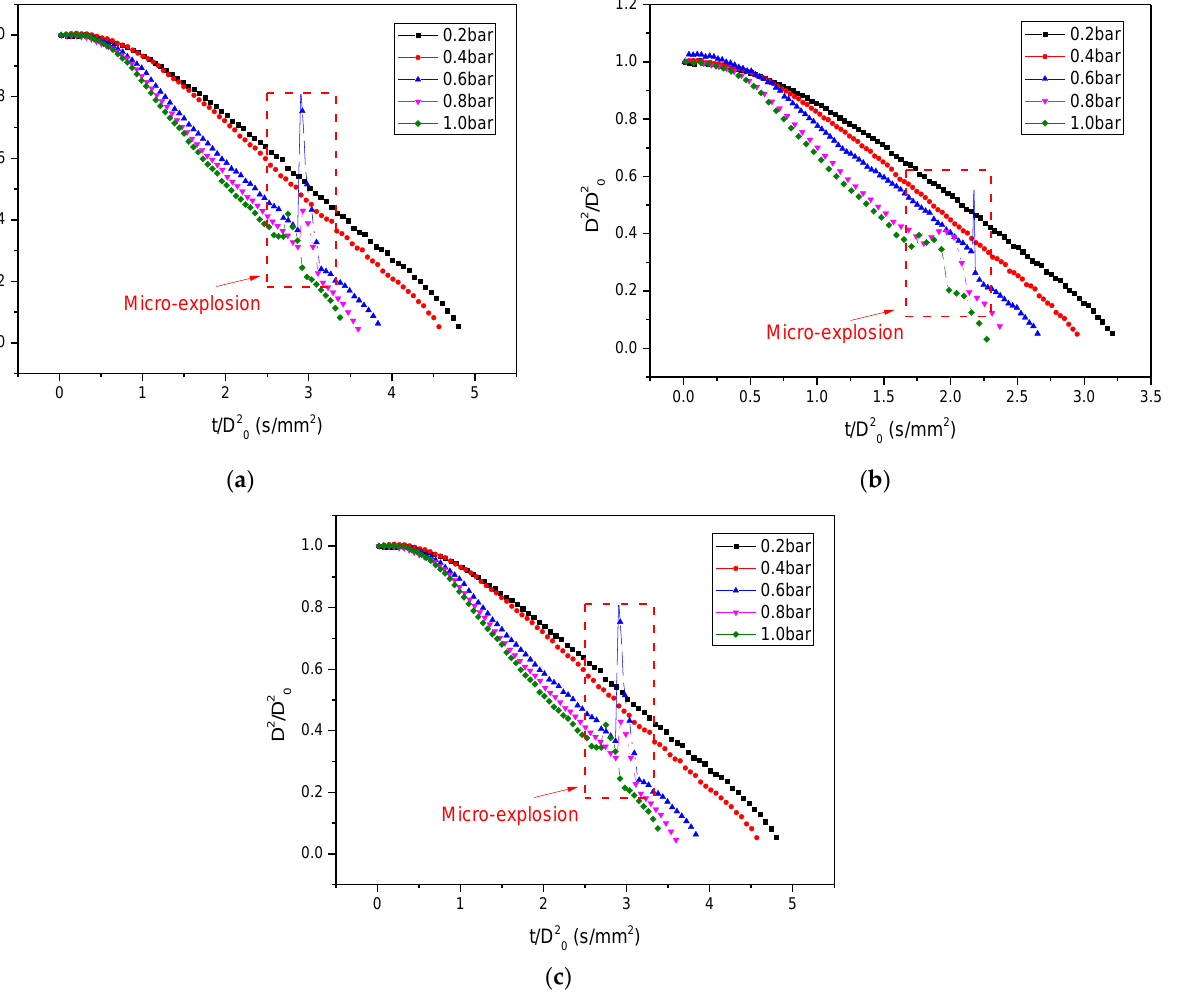
Figure 11. Influence of pressure on micro-explosion: ( a ) 673 K; ( b )773 K; ( c ) 823 K. The bubble growth rate is significantly higher at 0.6 bar compared to 0.8 bar, as During the diffusion controlled stage, the analytical solution of bubble growth in an shown in Figure 10. And at temperatures above 773 K, as the pressure drops from 0.8 to infinite mono-component liquid can be expressed as 0.6 bar, the droplet micro-explosion mode also changes from a puffing mode to a violently broken mode. Bubble growth is generally divided into three stages: (1) Inertia controlled stage; (2) Transition stage; (3) Diffusion controlled stage. Inertia controlled stage and dif- fusion control stage are the main process of bubble growth, and transition stage is the process of conversion between the two modes. During the inertia controlled stage, the bubble growth characteristics can be described by the following equation [46]: